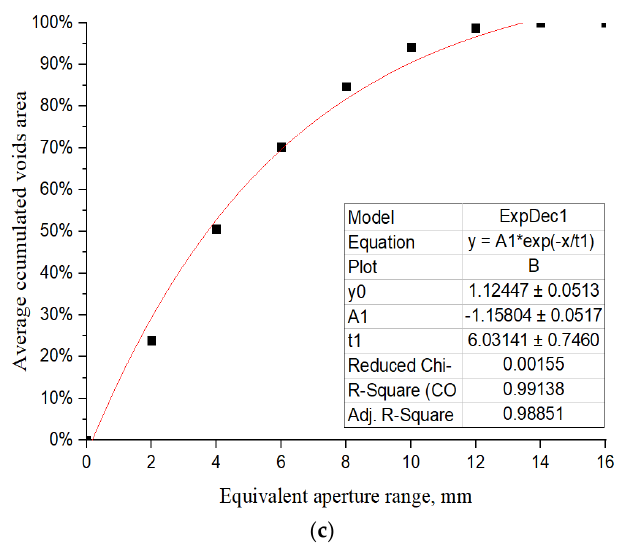
Figure 12. Relationship between accumulated voids area and the equivalent aperture, ( a ) OGFC sample I, ( b ) OGFC sample II, ( c ) Average value of OGFC samples.